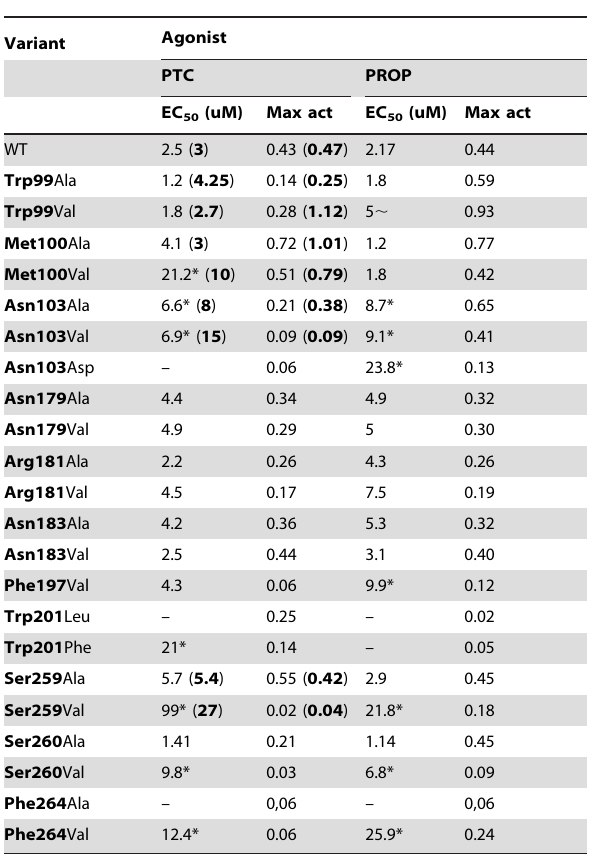
Table 2. Experimental EC 50 and maximum activity values towards PTC and PROP obtained for WT TAS2R38 and selected